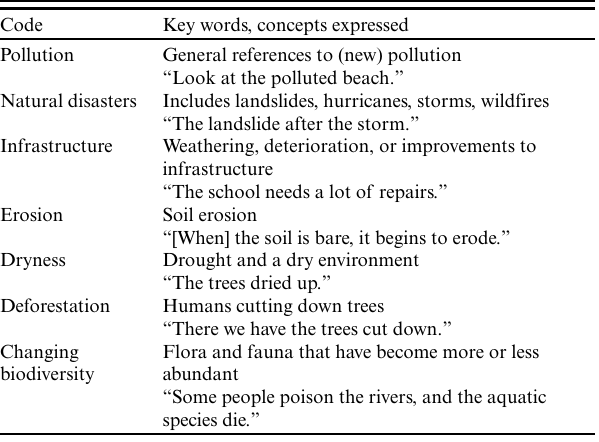
Table 6 . Codes for perceived environmental changes (prompt 3).